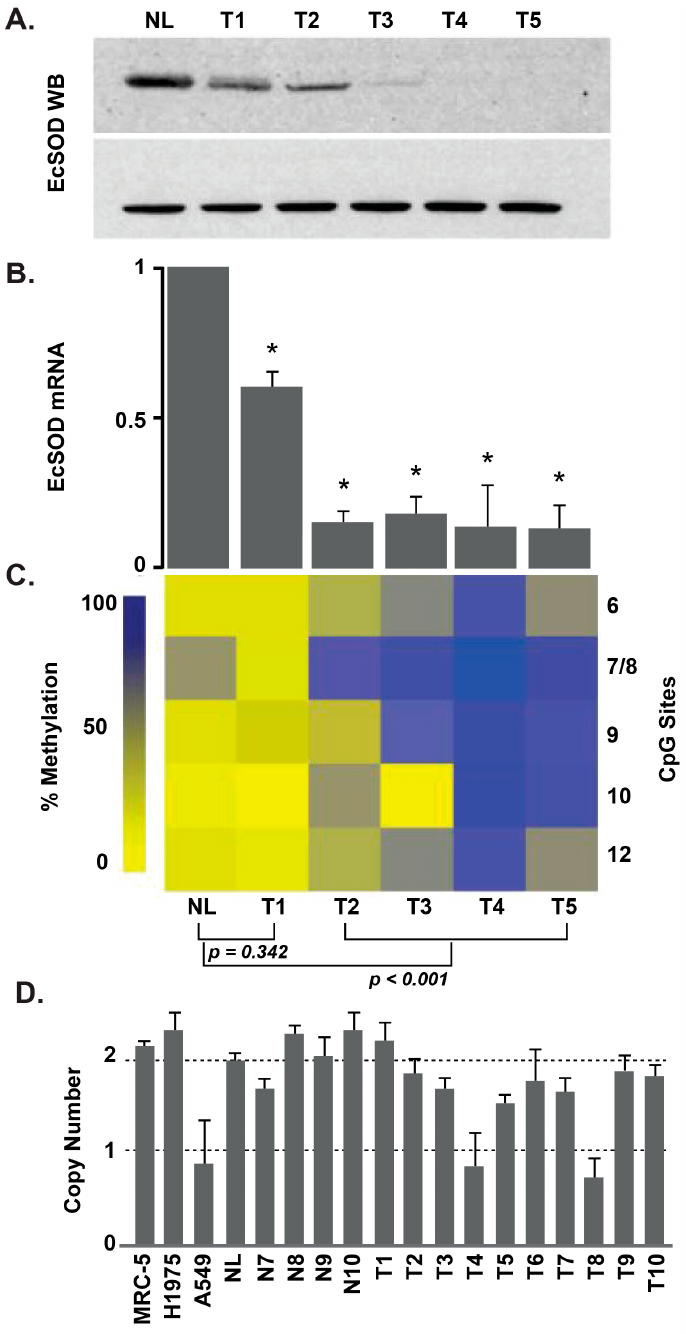
Figure 2. EcSOD protein and mRNA expression are decreased in lung adenocarcinoma, with frequent alterations in EcSOD promoter methylation. ( A ) Western blot for EcSOD. NL represents normal lung tissue while LT1-LT5 are lung adenocarcinoma tumor samples. The x axis represents the clinical sample labels for both panels A and B. ( B ) Expression of EcSOD mRNA, as determined by quantitative real-time RT-PCR. Each value is shown as a relative value compared to NL and normalized to 18S transcription level (* p < 0.05 vs. normal). ( C ) Heat map depicting the percent methylation of CpG sites 6–12 (right y axis) of the EcSOD promoter in NL and LT1-LT5. As depicted in the legend along the left y axis, low methylation is labeled in light yellow and the highest methylation in dark blue. ( D ) Results of TaqMan copy number variation assay in human lung cancer samples and cell lines. The y axis represents gene copy number, and the x axis represents clinical samples. Error bars, S.D. of each sample run in triplicate [37].